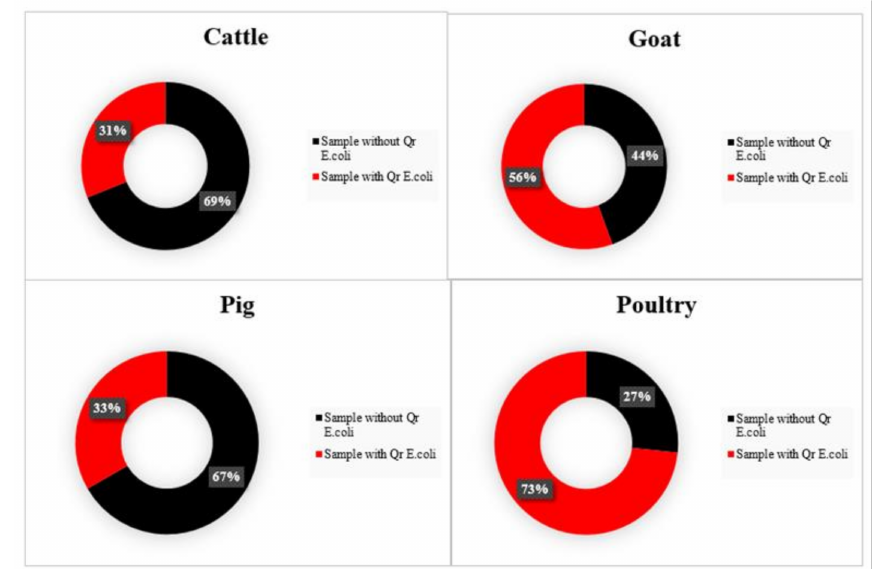
Figure 4. Recovery rates of Qr E. coli from cattle, goats, pigs, and poultry fecal samples in the East province of Rwanda. The total number of samples for each animal species was 45. Qr: quinolone